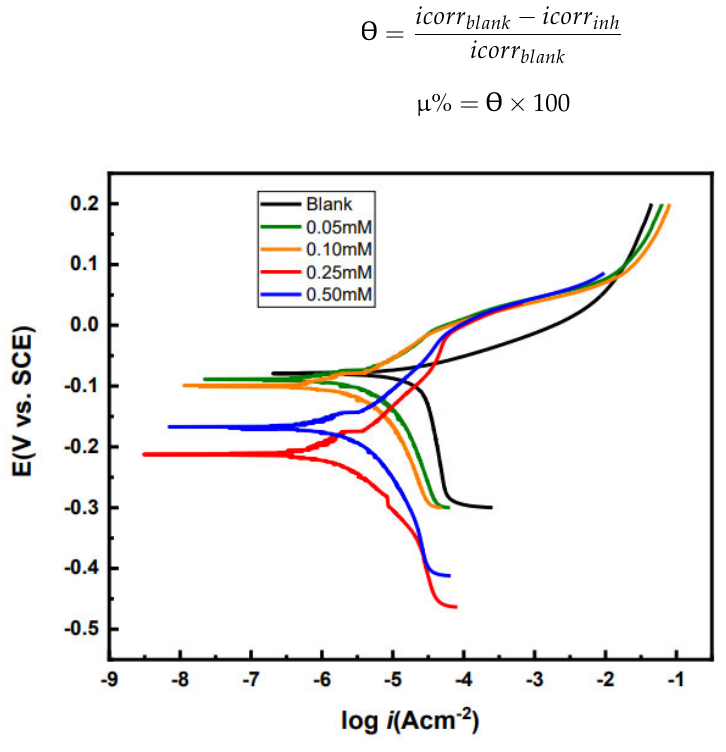
Table 2. Additionally, surface coverage (